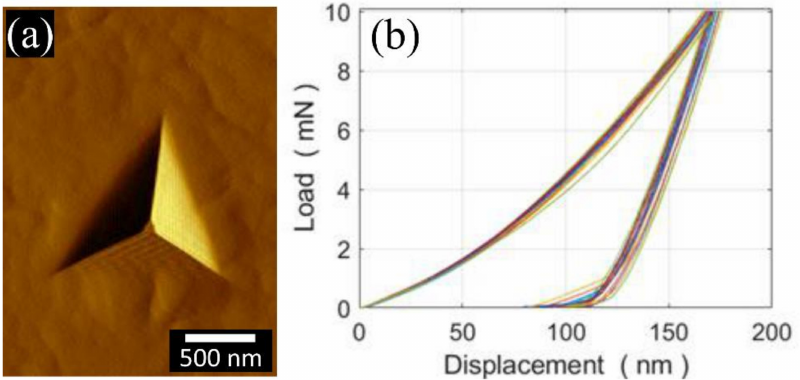
Figure 6. Nano-indentation across the HSS martensite matrix: ( a ) AFM force gradient in forward scanning mode of a typical imprint, ( b ) a selection of 20 (out of 30, for readability purposes) nano-indentation curves.